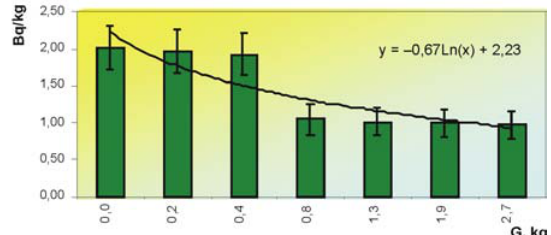
90 Sr activity and biomass in